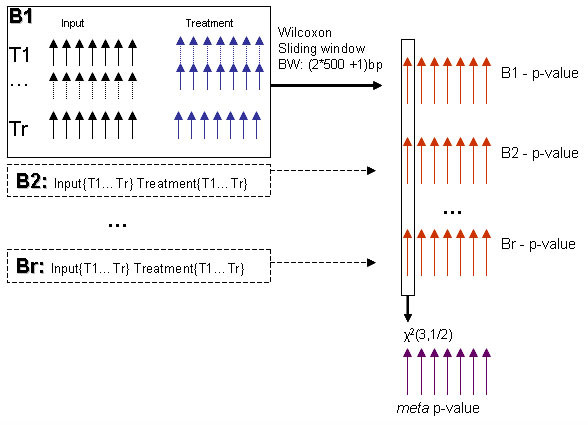
Schematic demonstrating the computation of a χ2 based meta p-value. A p-value distribution is generated per replicate following the computation of the one-sided upper tailed Wilcoxon test statistic. A meta p-value is generated per site by using a chi-square distribution across all the replicates.